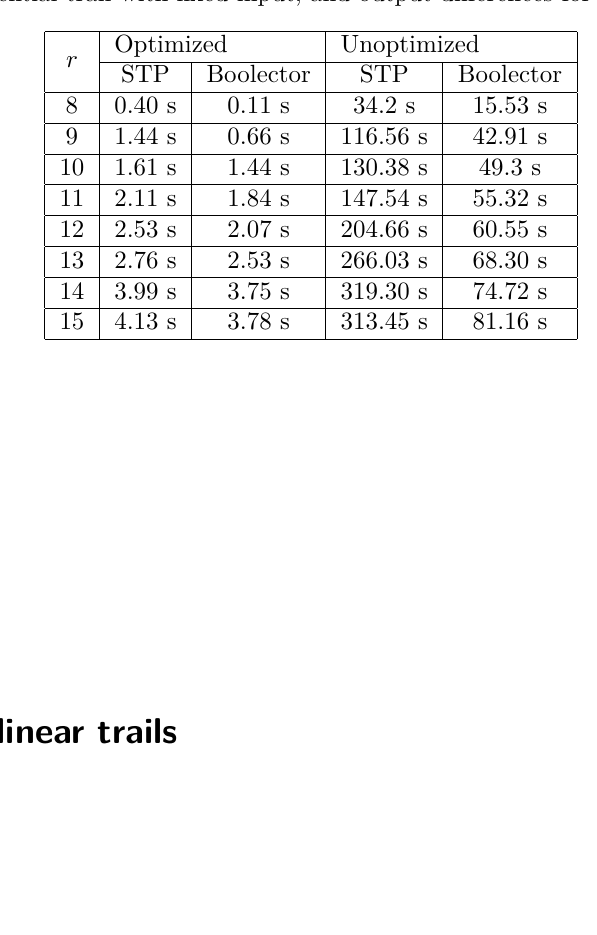
Table 10: A valid linear trail with weight 124, corresponding to the linear